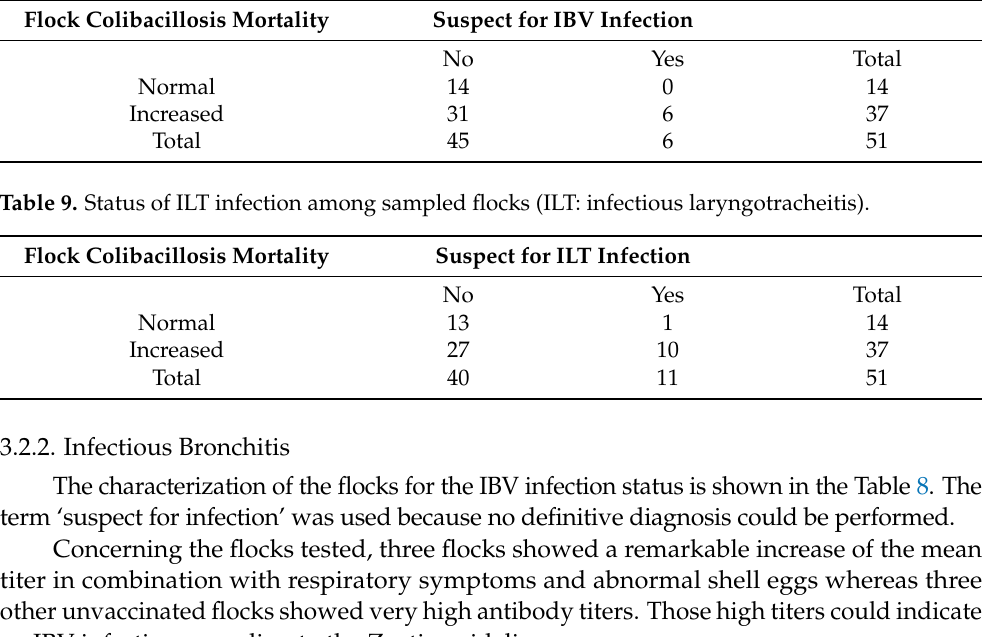
Table 8. Status of IBV infection among sampled flocks (IBV: infectious bronchitis virus). Flock Colibacillosis Mortality